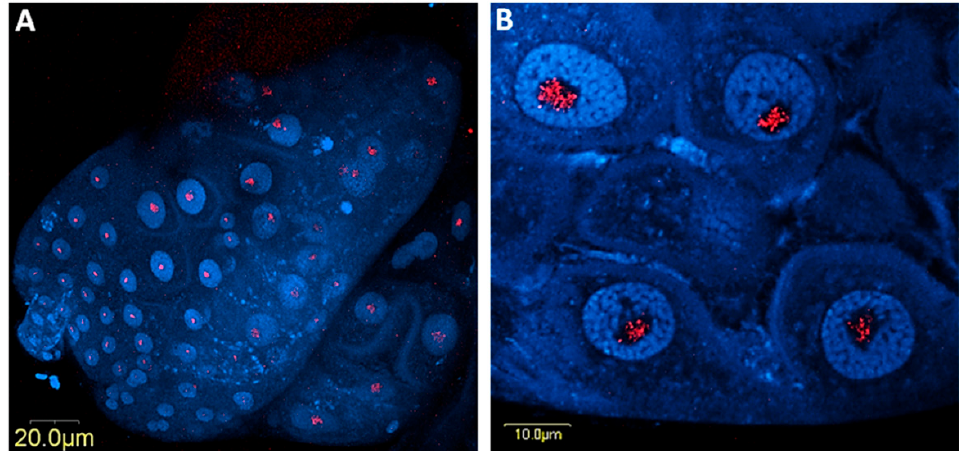
Figure 6. Immunolocalization of Sodalis (red) in B. trigonica midguts using anti- Sodalis monoclonal antibodies and cy3 labelled anti-mouse secondary antibody. The midgut nuclei were stained with DAPI (blue). A , the posterior midgut and B , in higher magnification showing four nuclei with Sodalis localized inside (red).